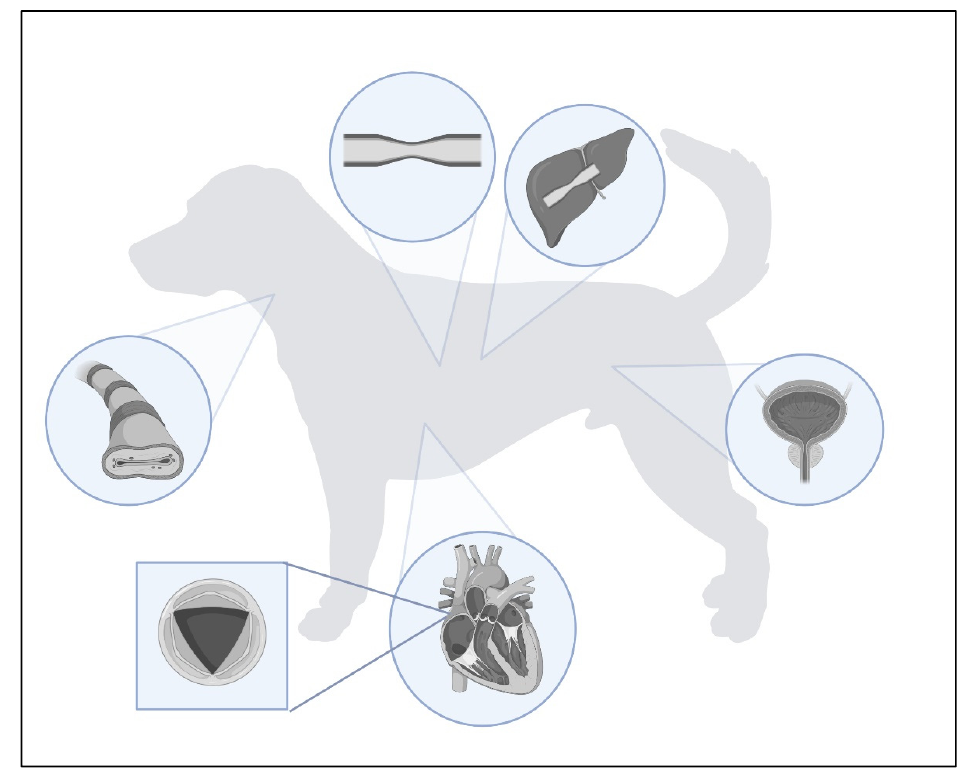
Figure 1. Use of stents in the treatment of canine and feline diseases.